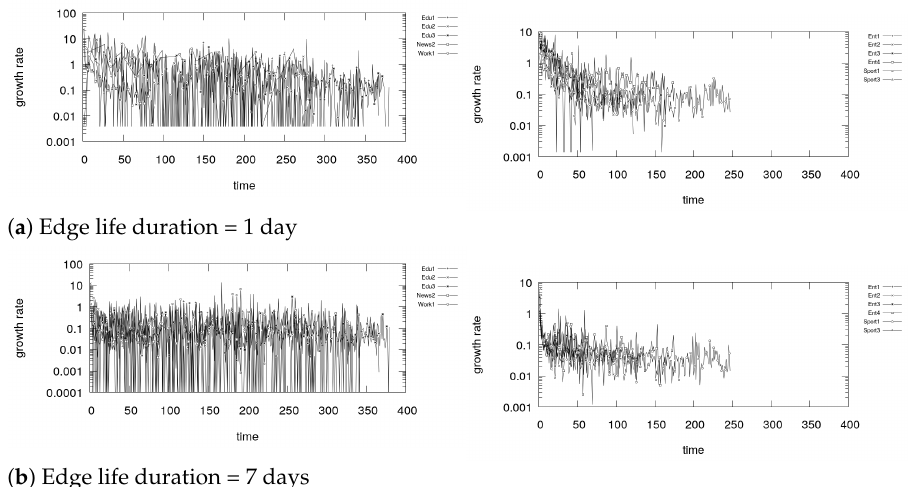
Figure 18. Growth rate of communities detected by